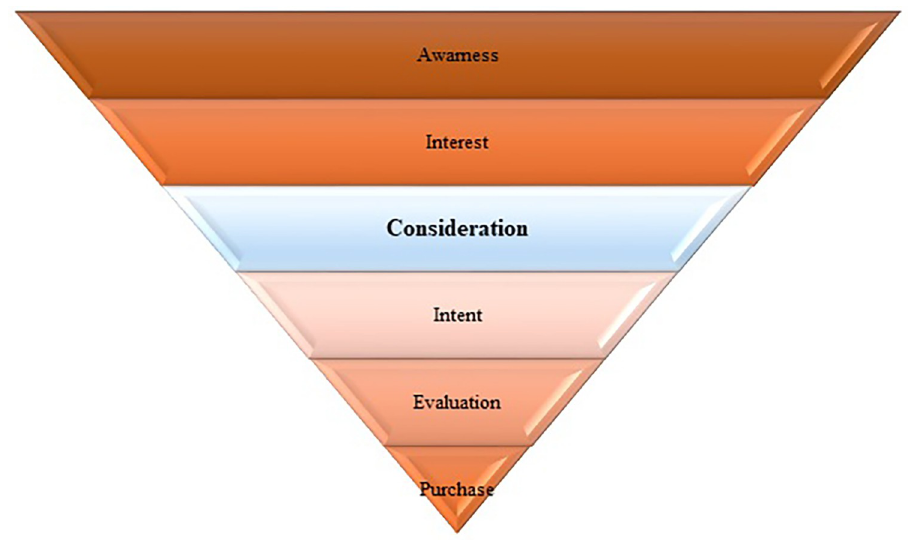
Fig 1. Model of purchase